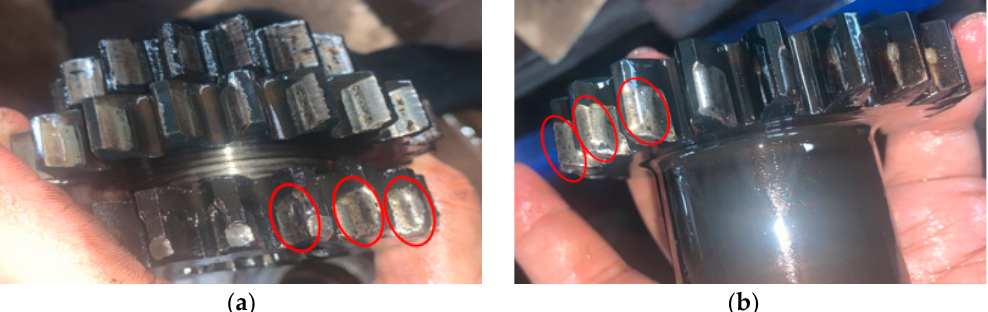
Figure 16. Damage of second drive gear ( a ) and second driven gear ( b ) inside the gearbox.